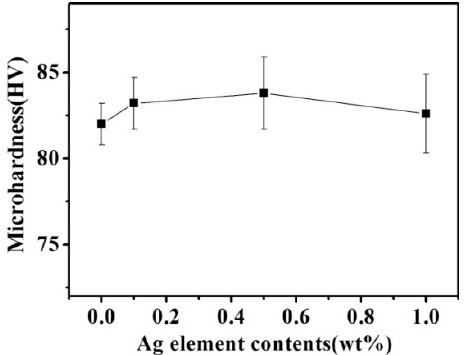
Figure 6. Cu matrix hardness of Cu–14Fe alloys solidified with the combined process.